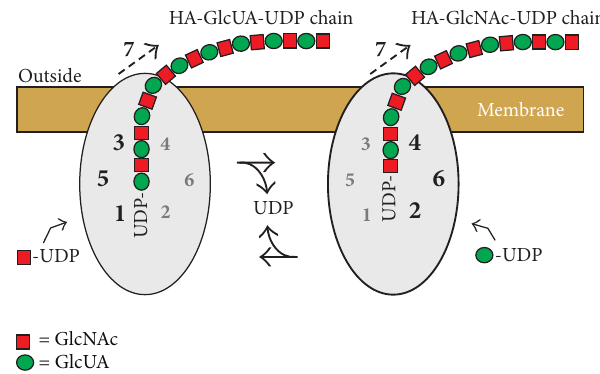
Figure 1: Schematic model of HAS showing the functions needed for HA chain growth at the reducing end and transfer to the cell surface. HAS uses multiple discrete functions (numbers 1–7) to assemble each HA disaccharide (red squares are GlcNAc and green circles are GlcUA). The same HAS protein is indicated in two different situations, at sequential times, as it alternately adds HA- GlcUA-UDP to a new GlcNAc-UDP, using functions 1, 3, and 5 (left), and then adds HA-GlcNAc-UDP to a new GlcUA-UDP, using functions 2, 4, and 6 (right). In this example (variant 1; Table 1) the sugar-UDPs are sequentially added in a continuous alternating manner and each cohort of needed functions cycles between being active (larger black numbers) and inactive (smaller gray numbers) within the active site domains (gray ovals). The functions required to add GlcNAc-UDP to HA-GlcUA-UDP are (left): 1, GlcNAc- UDP acceptor binding; 3, HA-GlcUA-UDP donor binding; 5, HA- GlcUA-UDP: GlcNAc-UDP, 𝛽 1,3(HA-GlcUA-) transferase; and 7, HA translocation through the membrane. The functions required